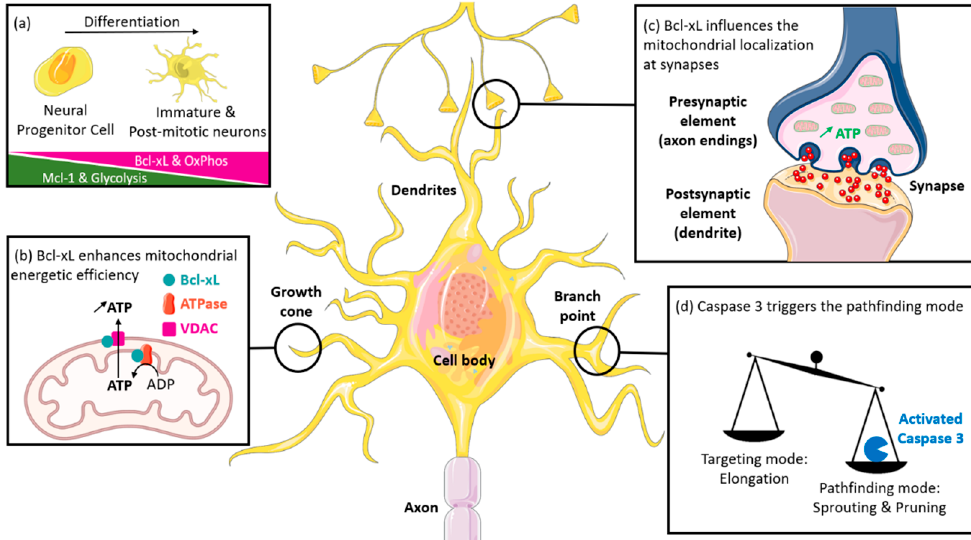
Figure 3. Main roles of Bcl-xL and caspase-3 in the nervous system. ( a ) During the development of the nervous system, neuronal progenitor cells (NPC) differentiate into immature neurons that may complete their differentiation and become post-mitotic and fully mature. This differentiation is associated with a metabolic switch from glycolysis to oxydative phosphorylation (OxPhos) and seems to be dependent on the expression of Bcl-xL. In differentiated neurons ( b ) mitochondria-addressed Bcl-xL, boosts the bioenergetics of the cell, by interacting with ATP synthase, which is critical for neurite outgrowth, and ( c ) allows the recruitment of mitochondria at the synaptic level via an unknown mechanism, which has a positive effect on synapse formation and function, including synaptic vesicle formation. ( d ) Caspase-3, a major apoptosis executioner, is required for the maturation of the nervous system. Indeed, caspase-3 promotes axonal branching so that neurites find their path to the proper target.